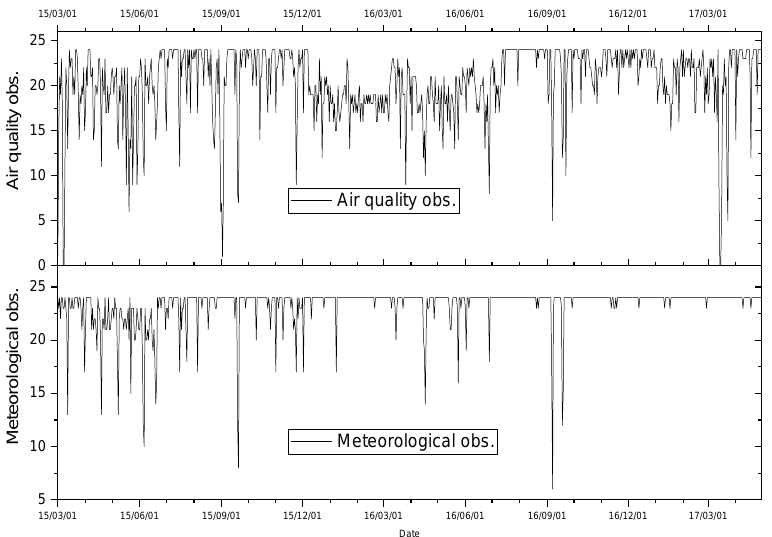
Meteorological obs.